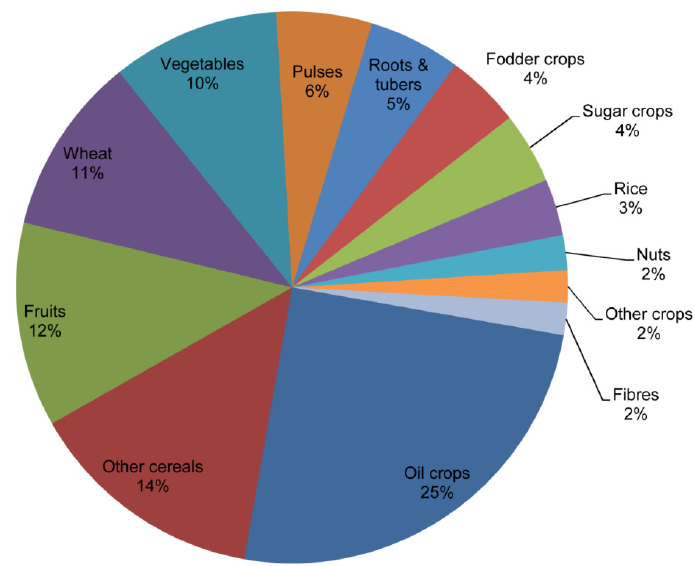
Figure 4. The contribution of different crops to the overall GWF of the EU consumption of agricultural products. Period: 2007.